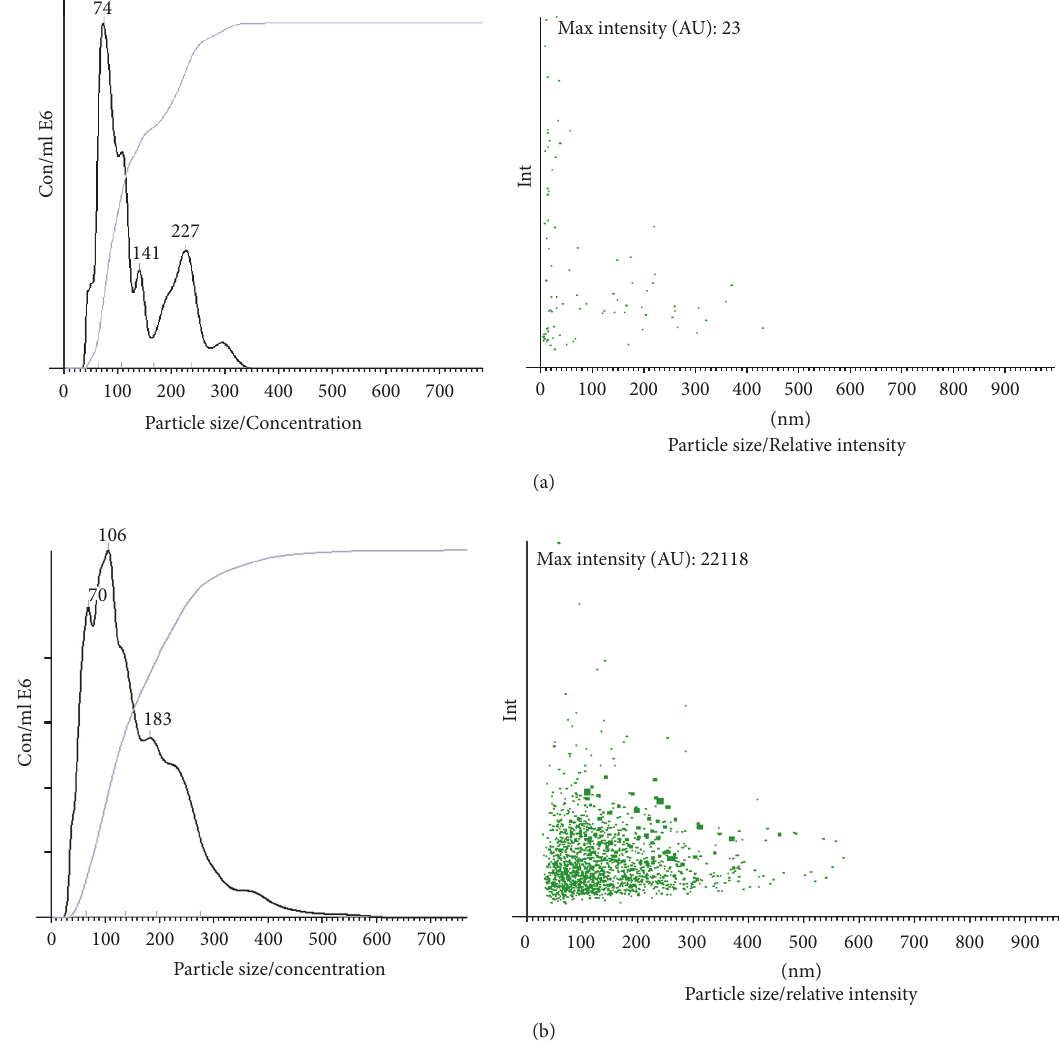
Figure 3: Nanosight analysis (representative analysis). (a) NTA analysis of an HIV-negative urine sample had 0.4 × 10 8 particles per ml (left panel) while (b) depicts an urine sample from a HIV+ patient that had 8.7 × 10 8 particles per ml and has a greater relative intensity profile (right panel (a) and (b)) when compared to the HIV-negative sample. The Rank Sum 𝑇 test showed that HIV+ patient urine samples had more particles per ml than the negative control urine ( 𝑃 < 0.05